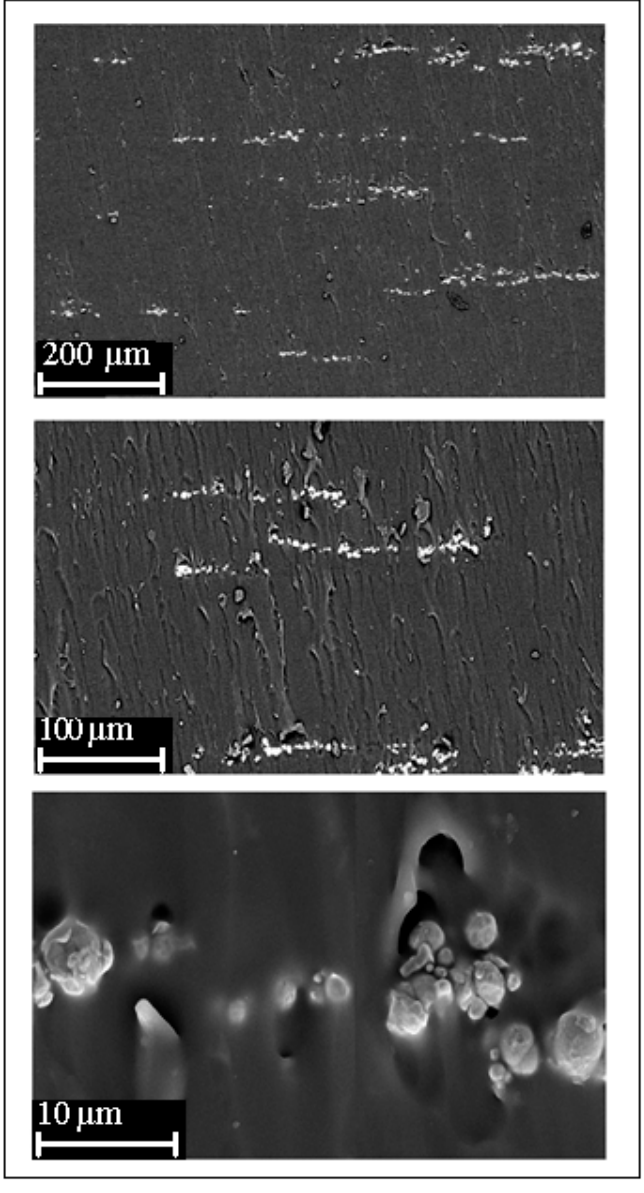
Figure 3. SEM of Fe-PDMS composites.